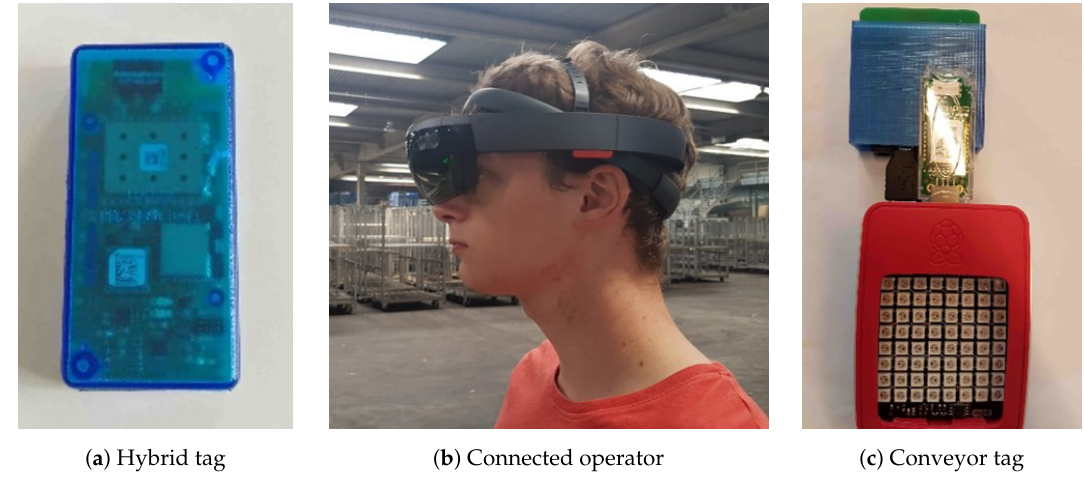
Figure 9. Prototypes for target use